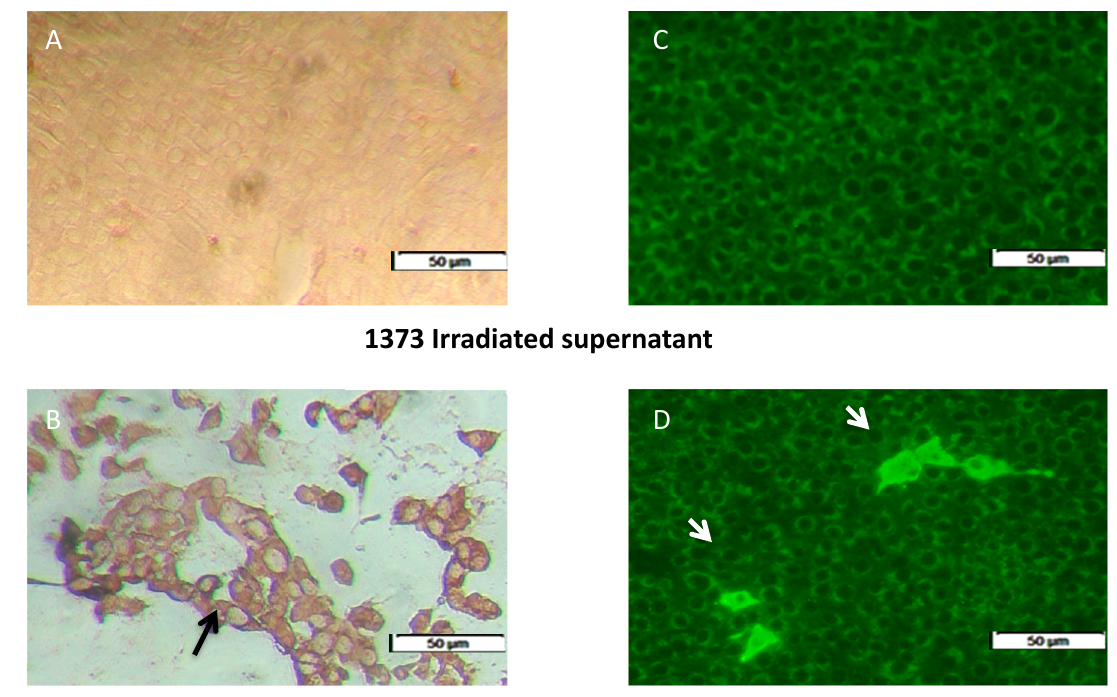
Figure 1. Successful inactivation of 1373-infected monocyte-derived macrophages (MDM) supernatant by UV-irradiation. ( A , C ) irradiated 1373-supernatant that show no evidence of intra-cytoplasmic replication by immune-peroxidase (IP) and immune-fluorescence (IF). ( B , D ) intra-cytoplasmic replication signal of the infected MDM supernatant, indicated by black and white arrows in the IP and IF assay, respectively ( B , D ).